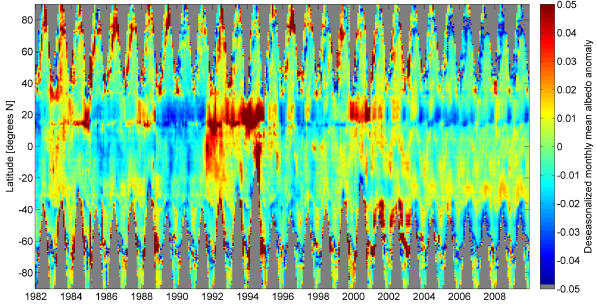
Fig. 11. A time-latitude representation of the deseasonalized monthly mean land/snow surface albedo anomalies vs. 1982–1998